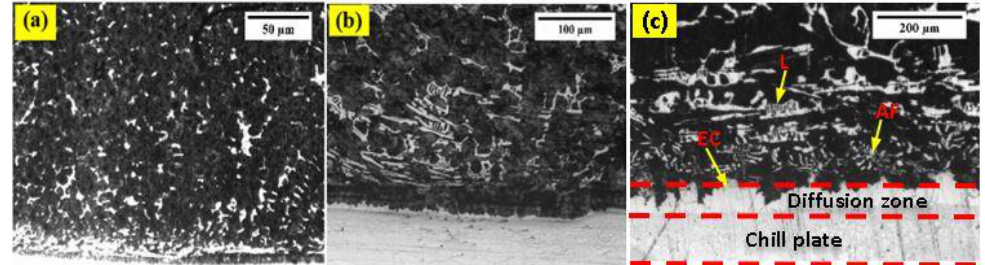
Figure 7: Average microstructure formation on the surface of the S2 samples. (a. Sample S1 microscopic magnification 50x; b. microscopic magnification 100x; c. microscopic magnification 200x). (AF=Acicular ferrite, EC=eutectic carbide; L=ledeburite.